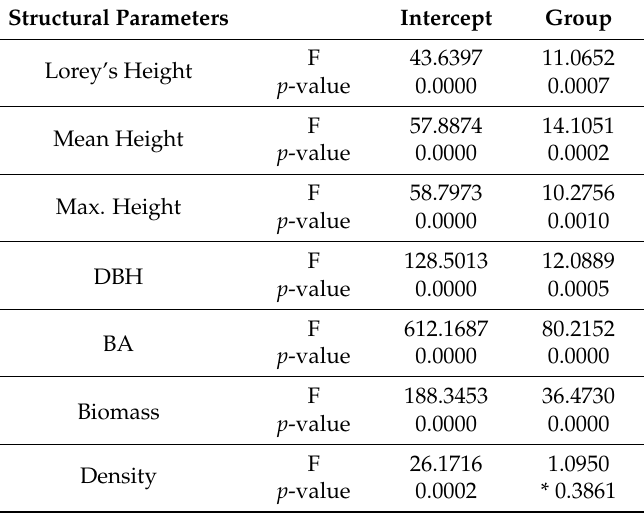
Table 3. Analysis of variance (ANOVA) of the structural parameters considering the groups formed in the cluster analysis of the plots ( p > 0.05).